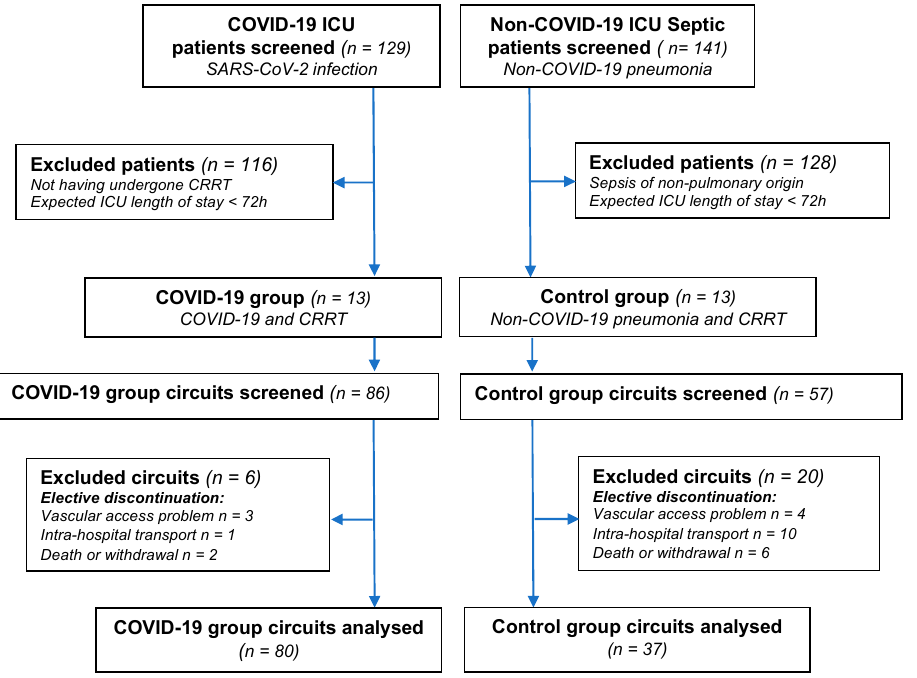
Figure 1. Flow chart of the study. Table 1. Characteristics of included patients.